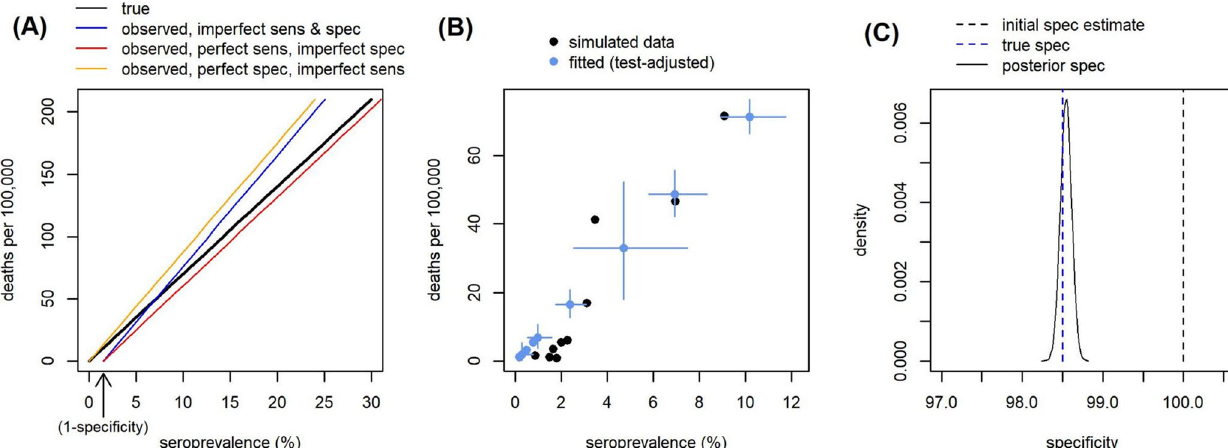
Fig. 4 Estimating serologic test speci fi city from regional data. A Expected relationship between seroprevalence and deaths per 100,000 under different values of serologic test sensitivity and speci fi city, when overall IFR = 0.7% and both IFR and population age structure are constant. B Example simulation of seroprevalence and deaths per 100,000 in different regions within a serosurvey (black), assuming varying burden of COVID-19 and population sizes between regions, but constant test performance and IFR. Model-estimated mortality and seroprevalence (adjusted for test performance) for each region when fi tting to the simulated data (blue; error bars = 95% CrI). Serologic test performance is simultaneously estimated by the model, using informative priors from a simulated validation study and the relationship between seroprevalence and mortality. C Initial prior speci fi city estimate based on a simulated validation study including 100 true negative cases (black dashed line); by chance 100% speci fi city was measured in the simulated validation study, although the true value is 98.5% (blue dashed line). The model fi tted to simulated regional data is able to infer a much more accurate posterior speci fi city estimate (black solid line shows posterior distribution).